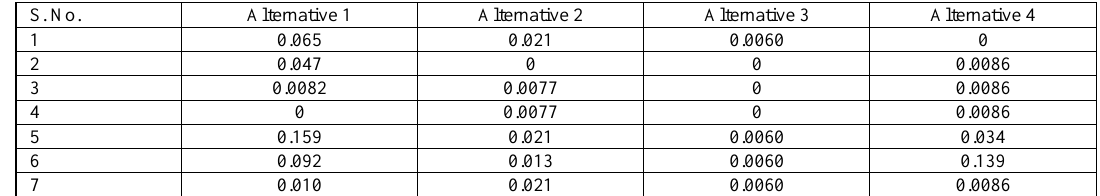
Table 13. Distances of each alternative from negative idle